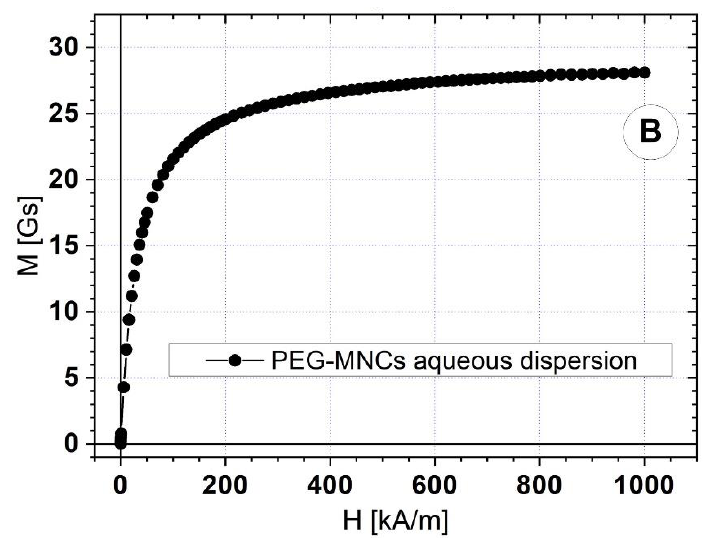
Figure 7. Magnetization curves for ( A ) a sample of dry PEG-MNCs, and ( B ) PEG_MNCs aqueous dispersion at room temperature (25 °C).